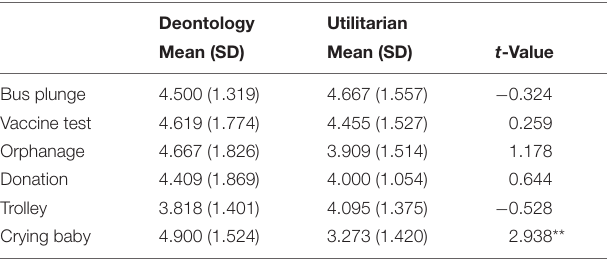
TABLE 5 | Appropriateness rating by deontological and utilitarian choice for each dilemma scenario.